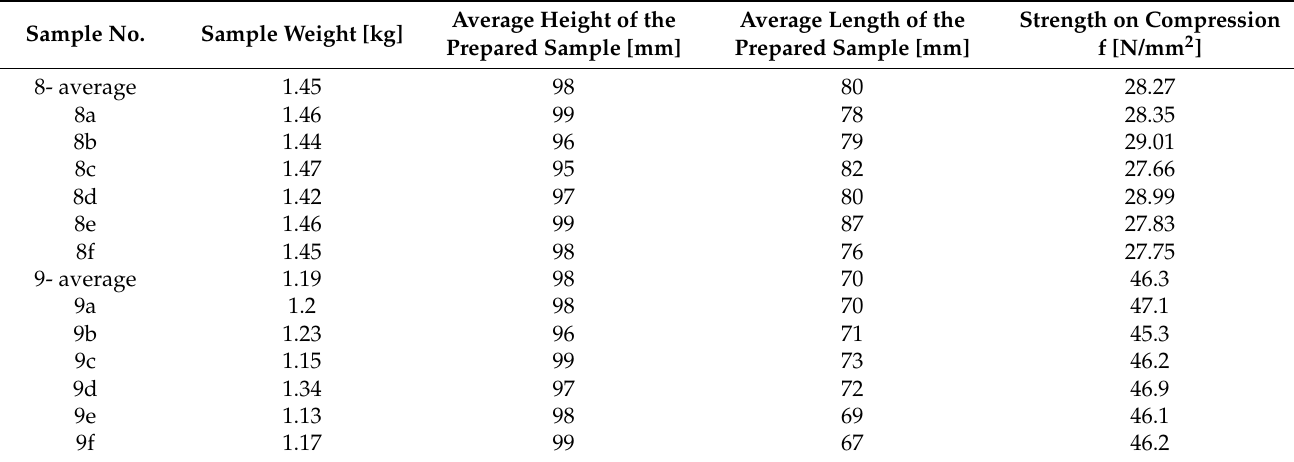
Figure 13. A view of statistics ( a ) samples 8a–f; ( b ) samples 9a–f. Table 3. Strength test results for sample no. 8,